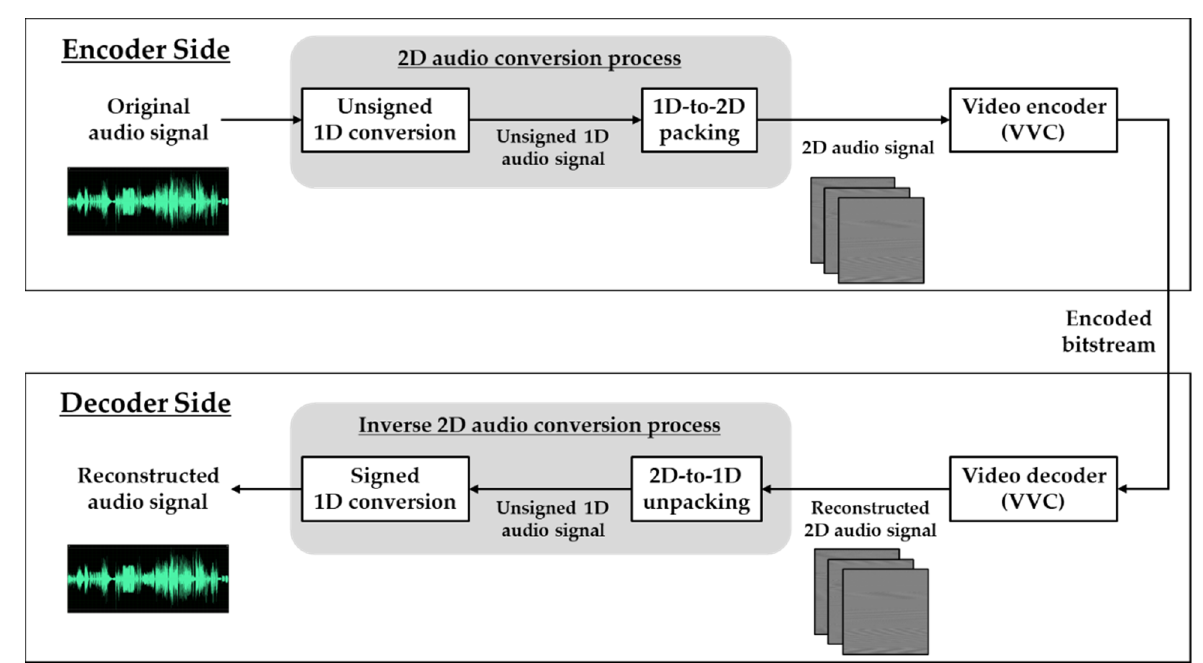
Figure 3. Overall architectures of VVC-based 2D audio coding.